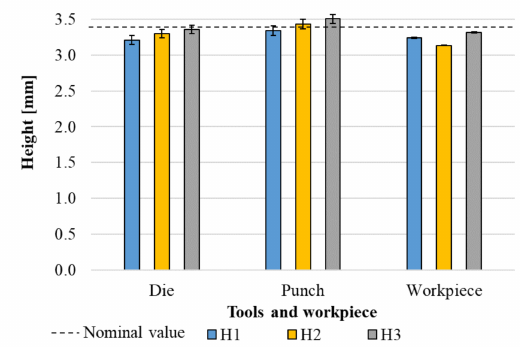
Figure 11. Average groove height in workpiece and tools compared to the nominal height 3.4 mm.